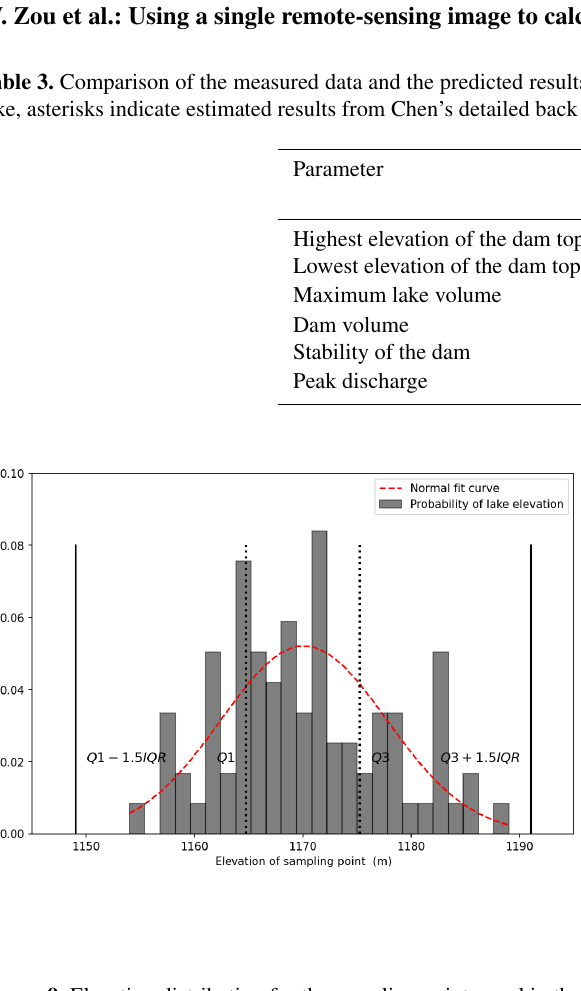
Figure 9. Elevation distribution for the sampling points used in the case of the Hongshiyan landslide dam.